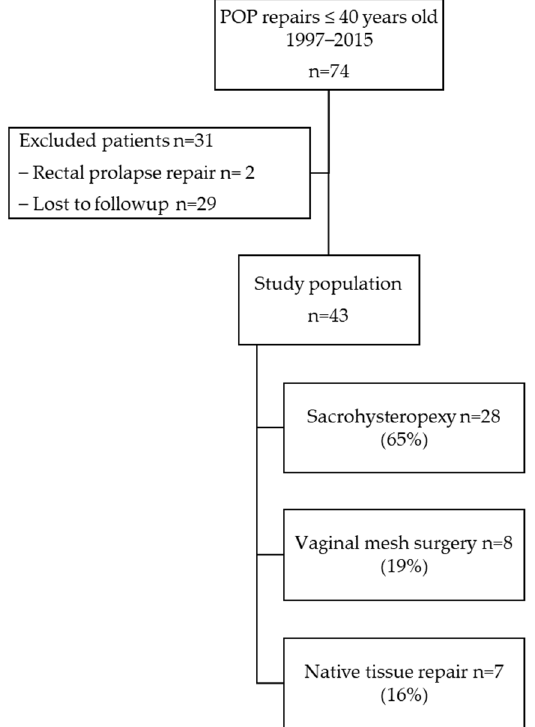
Figure 1. Flow chart. Table 1. Population